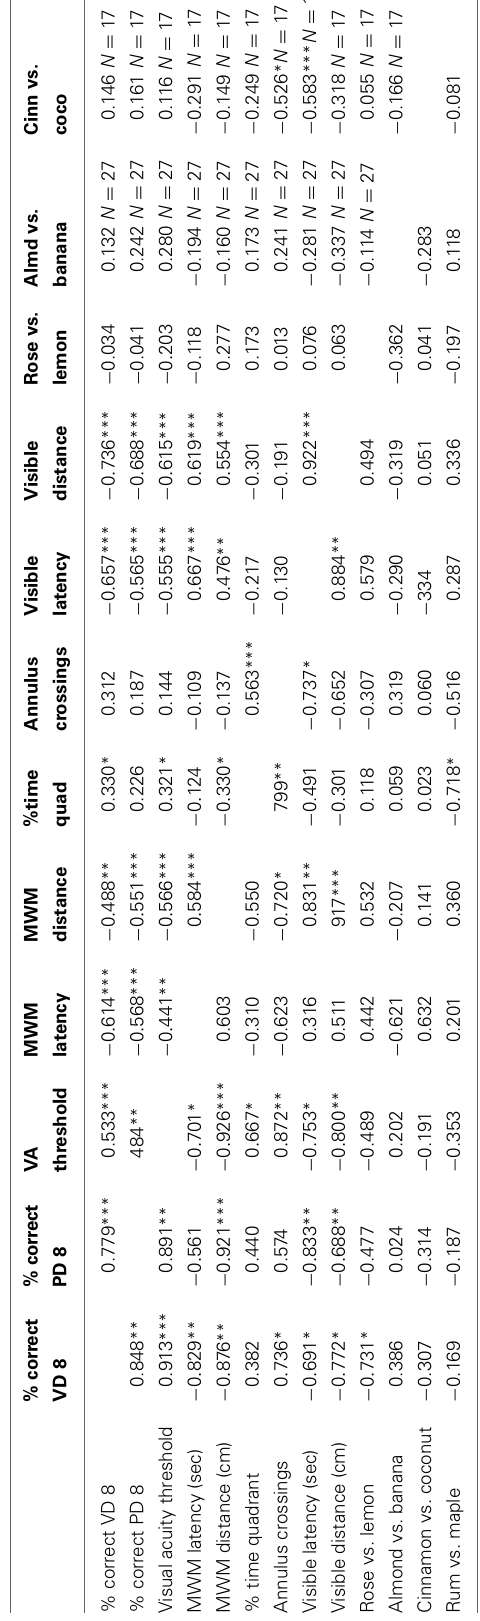
Although the dissociation between visuo-spatial and odor memory tasks does not support the “common cause” hypothesis of aging, both the “sensory deprivation” and the “resource allo- cation” hypotheses predict that improvement of sensory function should result in an improvement of cognitive ability. However, the poor performance of 0.50% Timoptic-XE mice in the long-term odor memory task conducted at 12 months of age is inconsis- tent with the prediction that mice with improved visual function should also show a corresponding improvement in odor